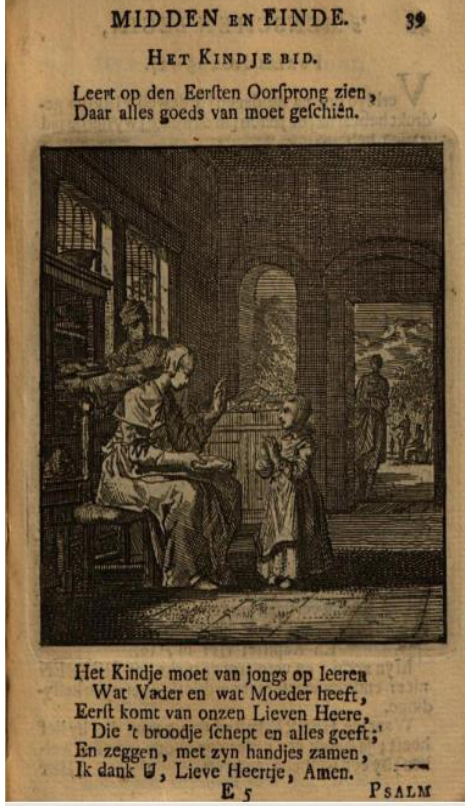
Figure 3. Jan Luyken, “ Het Kindje Bid ”. Het Kindje Bid. Leerd op den Eersten Oorsprong zien, Daar alles goeds van moet geschi ê